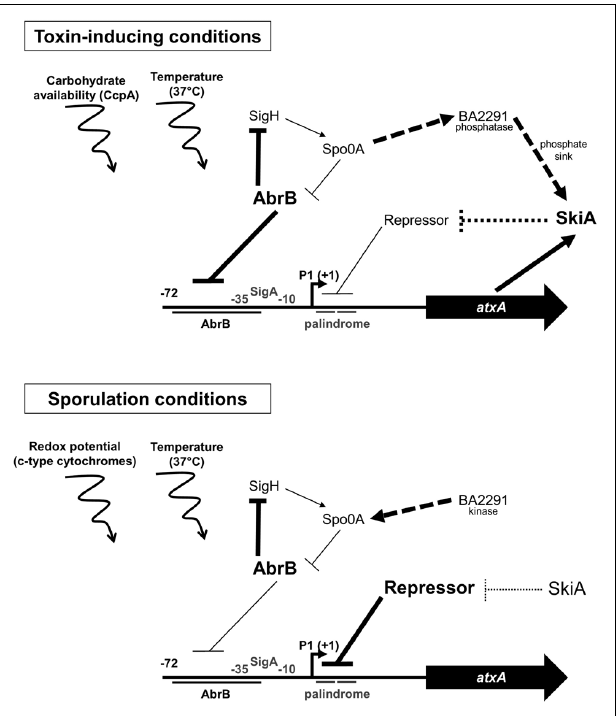
FIGURE 6 | Model for regulation of atxA gene expression in toxin-inducing and sporulation conditions. The developmental regulators AbrB, Spo0A, and SigH regulate atxA transcription in a condition-dependent manner. In toxin-inducing conditions, AbrB binds to a region upstream of P1 to actively repress atxA expression, whereas in sporulation conditions, AbrB plays a minor role in control of atxA . In toxin-inducing conditions, atxA positively controls skiA transcription. In sporulation conditions, the atxA repressor protein (referred to as ‘Repressor’ in the model) interacts with a palindromic sequence located downstream of P1 (Dale et al., 2012). Activity of the repressor is down-regulated by SkiA. BA2291 is a sensor histidine kinase that indirectly activates Spo0A in sporulation conditions, and acts as a phosphatase in toxin-inducing conditions. SkiA acts as a phosphate sink in a BA2291-dependent manner in toxin-inducing conditions. Additional signals impacting atxA expression are carbohydrate availability, temperature, and redox potential. Thick lines denote important trans -acting factors or signals controlling atxA expression in the given culture condition. Thin lines denote minimal impact. Hashed lines indicate suggested or indirect (BA2291) functions. Curved lines/arrows represent indirect effects on atxA